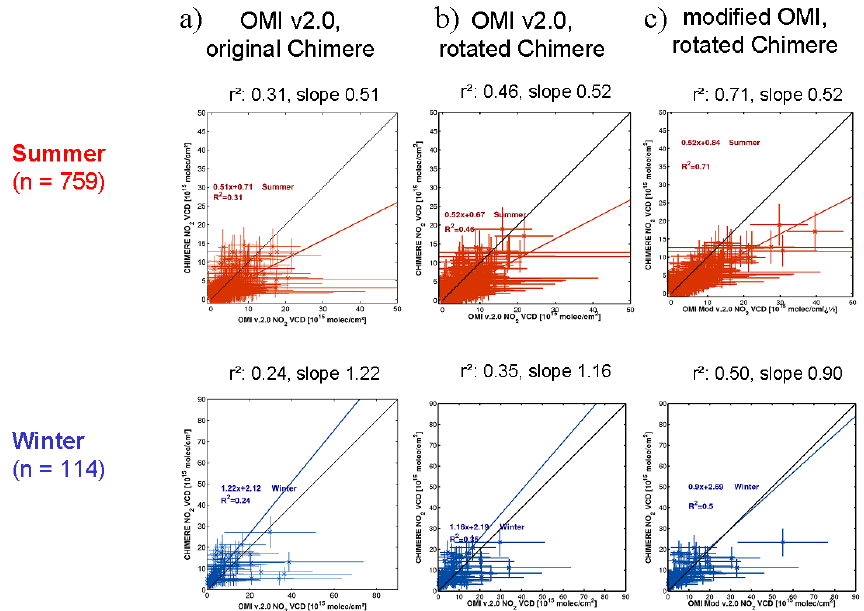
Figure 19. Correlation analyses between CHIMERE and OMI observations (for CF <30%) for (a) the original data sets, (b) rotated CHIMERE data, and (c) rotated CHIMERE data and modified OMI data.